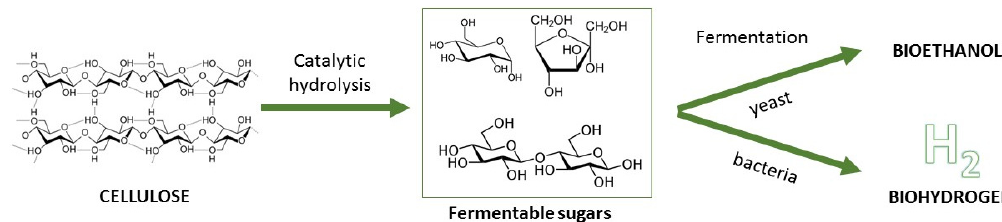
Figure 6. Conversion of biomass to biofuels by combined catalytic and biological processes (Adapted from